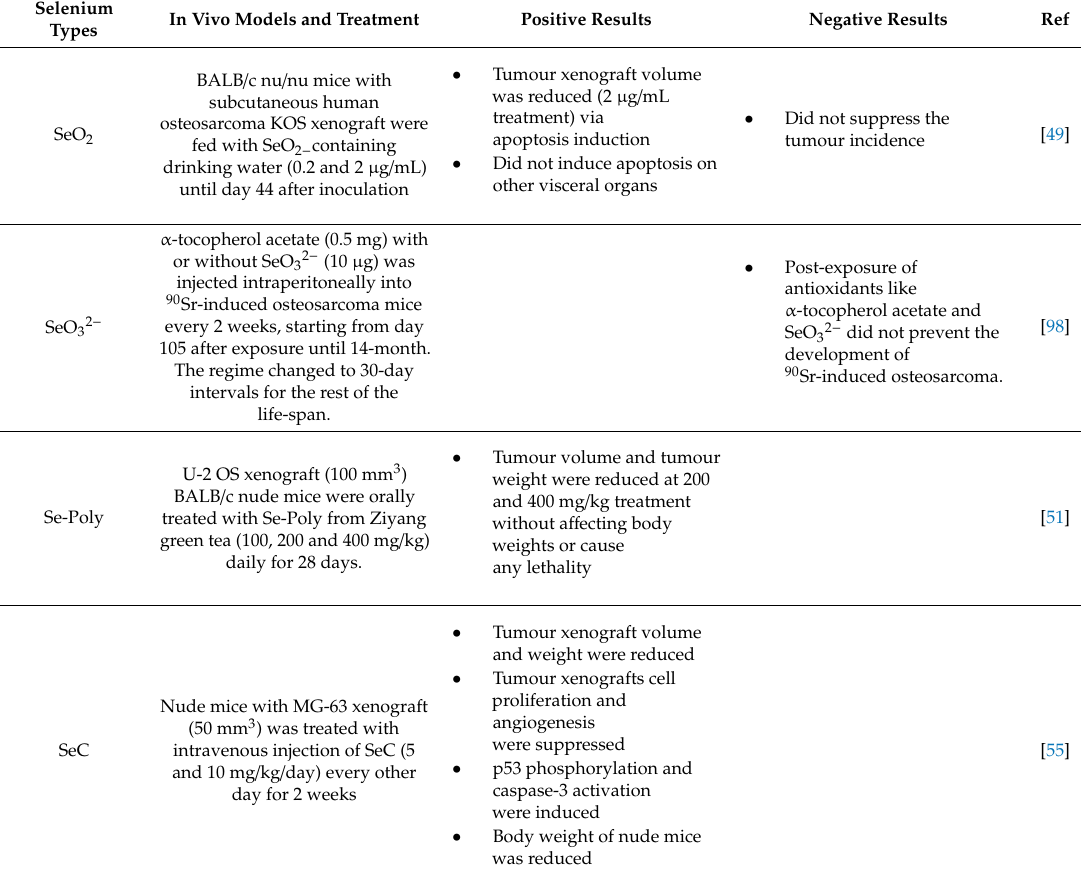
Table 2. The e ff ects of selenium in osteosarcoma animal and human